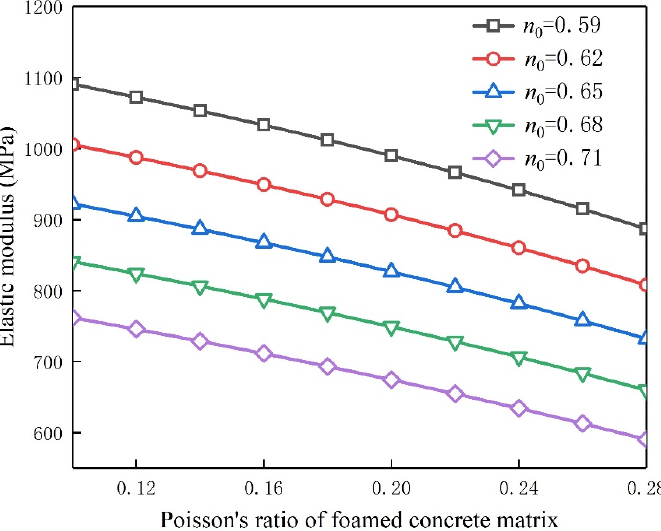
Figure 15. Variation in elastic modulus of foamed concrete with Poisson’s ratio of matrix.